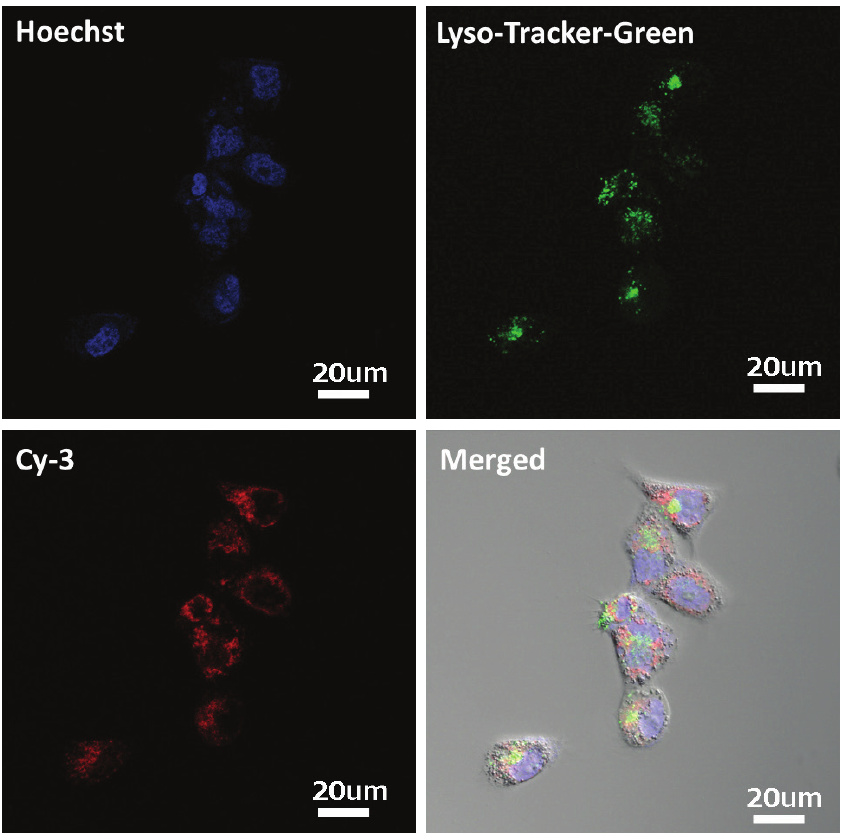
Figure 6: High magnification (×400) laser confocal microscopic images of PC-3 cells incubated with PEG-PEI/miR-scr polyplexes (N/P=20). Dose of miR-scr: 100nM. Blue: nuclei stained with Hoechst; red: miR-scr labeled with Cy3; green: lysosomes labeled with Lyso-Tracker green. a: Figure of nuclei stained with Hoechst b: Figure of lysosomes labeled with Lyso-Tracker green c: Figure of miR-scr labeled with Cy3 d: Figure of merging the three fluorescent images